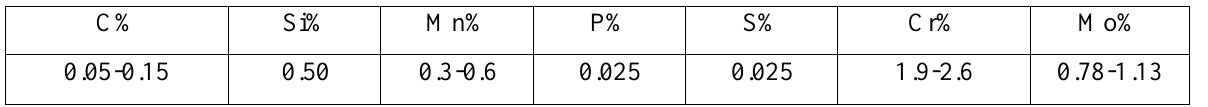
Table 1: Composition of low alloy